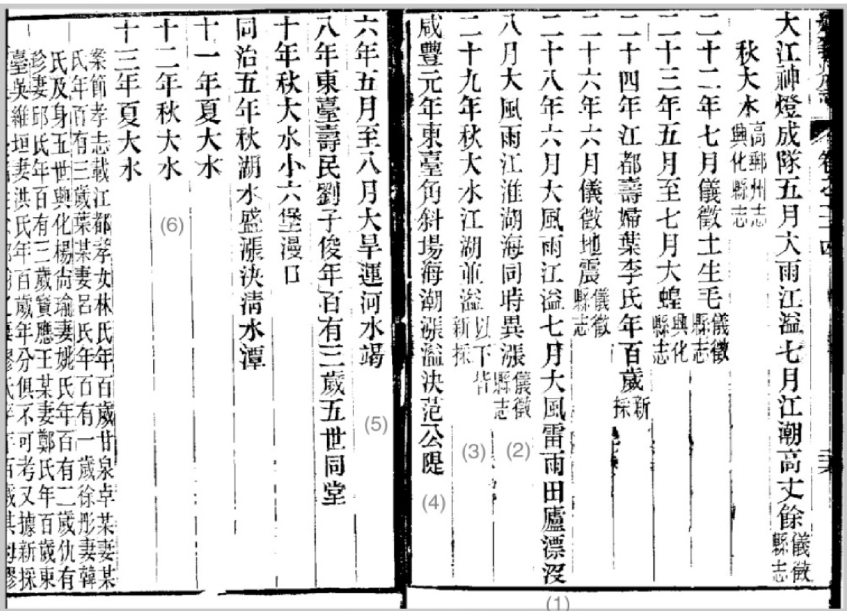
Figure 2. An example of anomalous climate information recorded in local gazettes (quoted from Gazettes of Yangzhou Prefecture , compiled in 1874). The two pages list anomalous climate information in that region from 1842 to 1874, which is read from right to left, and dated according to the Chinese lunar calendar. Numbers in parenthesis are added by the authors to show meaning. (1) In the 28th year (of the Daoguang Emperor, 1848), the sixth month, due to the strong wind and heavy rain, the Yangtze River overflowed; the seventh month, because of strong wind and thunderstorms, fields and houses were submerged. (2) In the eighth month there was strong wind and heavy rain; the level of the Yangtze River, the Huai River, the Gaoyou Lake, and the sea abnormally rose at the same time; the citation from Gazettes of Yizheng County (a county in the prefecture), where records of “strong wind” and “the sea level abnormally rose” also suggested heavy rain induced by a typhoon. (3) There was a flood in the autumn of the 29th year (1849); the Yangtze River and the (Gaoyou) Lake overflowed at the same time. Notes of “below are newly collected”, suggest that these records were quoted from earlier local gazettes. (4) In the first year of Emperor Xianfeng (1851), in Jiaoxiechang (the name of a salt field) in Dongtai County (a county in the prefecture), the tide from the sea overflowed and broke the seawall of Mr. Fan. (5) The sixth year (1856), the fifth to eighth months, there was severe drought and the Grand Canal dried up. (6) Autumn of the 12th year of Emperor Tongzhi (1873), there was a flood. This picture is taken by the author from the original file, which is stored in the library of the Institute of Geographic Sciences and Natural Resources Research, CAS. We obtained the rights to use and publish this